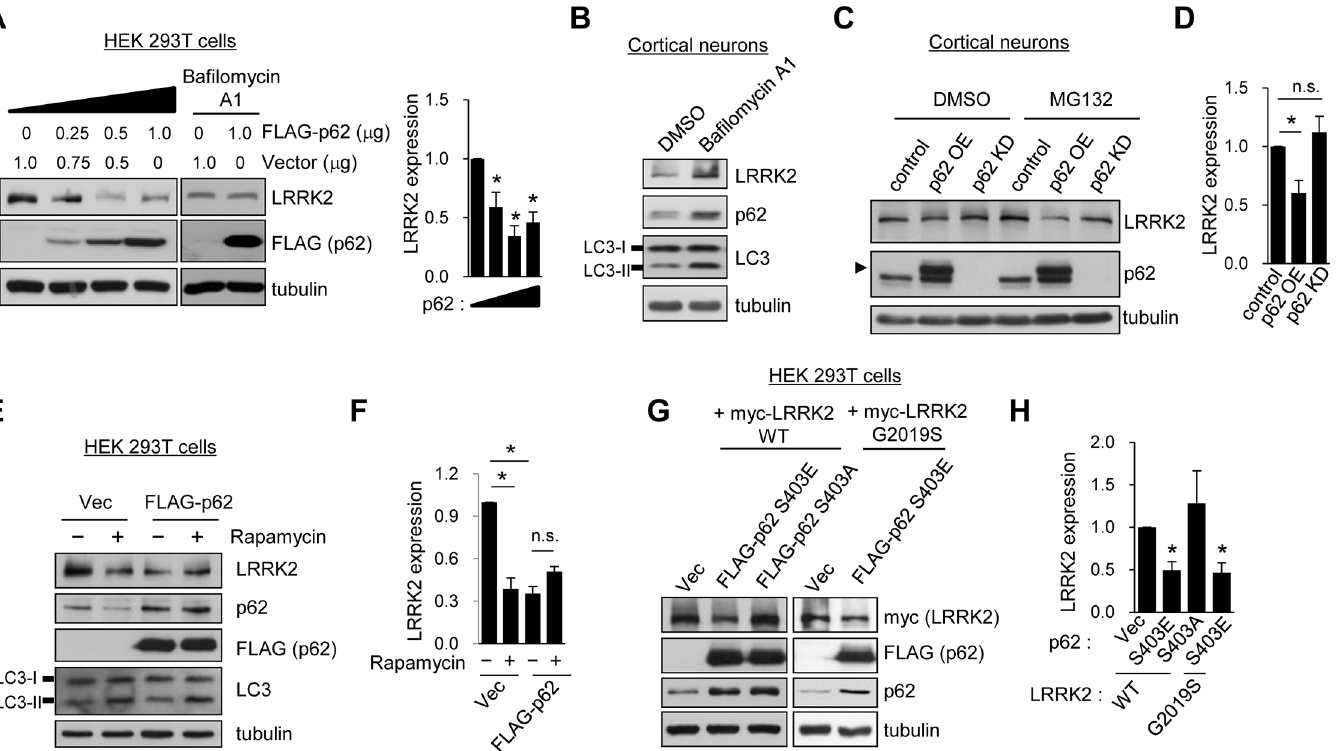
Fig 4. Stability of LRRK2 is regulated by p62. A . HEK 293T cells were transfected with 0.25, 0.5, or 1.0 μ g FLAG-p62 expression plasmid or control vector for 24 h. Bafilomycin A1 was treated for 2 h. Endogenous LRRK2 expression was detected with western blotting by using LRRK2 antibody from total cell lysates. Quantification data from panel A represent means of LRRK2 expression ± SEM (Vec, 1.00 ± 0.00; 0.25 μ g p62, 0.59 ± 0.12; 0.5 μ g p62, 0.34 ± 0.15; 1.0 μ g p62, 0.46 ± 0.15; n = 3; * p < 0.05, paired t -test). B . Primary cortical neurons were treated with bafilomycin A1 for 2 h and endogenous protein levels were detected with western blotting using the indicated antibodies. C . Primary cortical neurons were infected with lentivirus that overexpress GFP (control) or p62 (p62 OE) under a ubiquitin promoter. Neurons were also infected with lentivirus that harbor p62 small hairpin RNA (shRNA) under an H1 promoter to knock down the expression of p62 (p62 KD). Five to seven days after infection, the neurons were treated with DMSO or 5 μ M MG132 for 2 h. Endogenous LRRK2 expression was examined with western blotting. Arrowhead indicates the exogenous expression of 3 X FLAG-tagged p62, in which bands were shifted owing to the increased molecular weight of p62 fused with three tandem FLAG epitopes. D . Quantification of band intensity of LRRK2 relative to that of the control is shown. Means ± SEM (control, 1.00 ± 0.00; P62 OE, 0.60 ± 0.11; p62 KD, 1.12 ± 0.49; n = 4 for p62 OE, n = 13 for p62 KD; * p < 0.05, n.s. indicates p > 0.05, paired t -test). E . A FLAG-p62 expression plasmid was transfected in HEK 293T cells. Twenty-four hours after transfection, the cells were treated with 100 nM rapamycin for 2 h, and protein expression levels were analyzed with western blotting with the indicated antibodies. F . Bar graph data represent the means of normalized LRRK2 expression ± SEM (Vec, 1.00 ± 0.00; Vec with rapamycin, 0.39 ± 0.08; p62, 0.35 ± 0.05; p62 with rapamycin, 0.51 ± 0.04; n = 3, * p < 0.01, n.s. indicates p > 0.05, paired t -test). G . HEK 293T cells were co-transfected with WT or G2019S myc-LRRK2 and phosphomimetic mutant FLAG-p62 Ser403Glu (S403E) or dephosphorylated mutant Ser403Ala (S403A). LRRK2 expression was detected with western blotting. H . Bar graph data represent the means of normalized LRRK2 expression ± SEM from panel G (Vec, 1.00 ± 0.00; S403E, 0.50 ± 0.01; S403A, 1.28 ± 0.66; S403E in G2019S, 0.47 ± 0.11; n = 3 – 4, * p < 0.05, paired t -test).